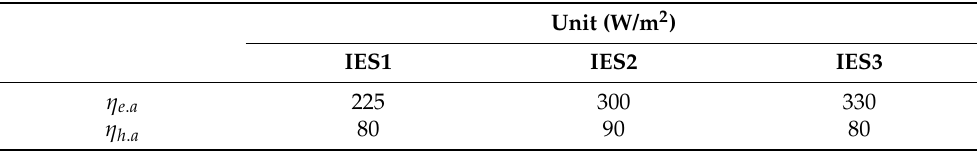
Table 1. Oxygen load-related